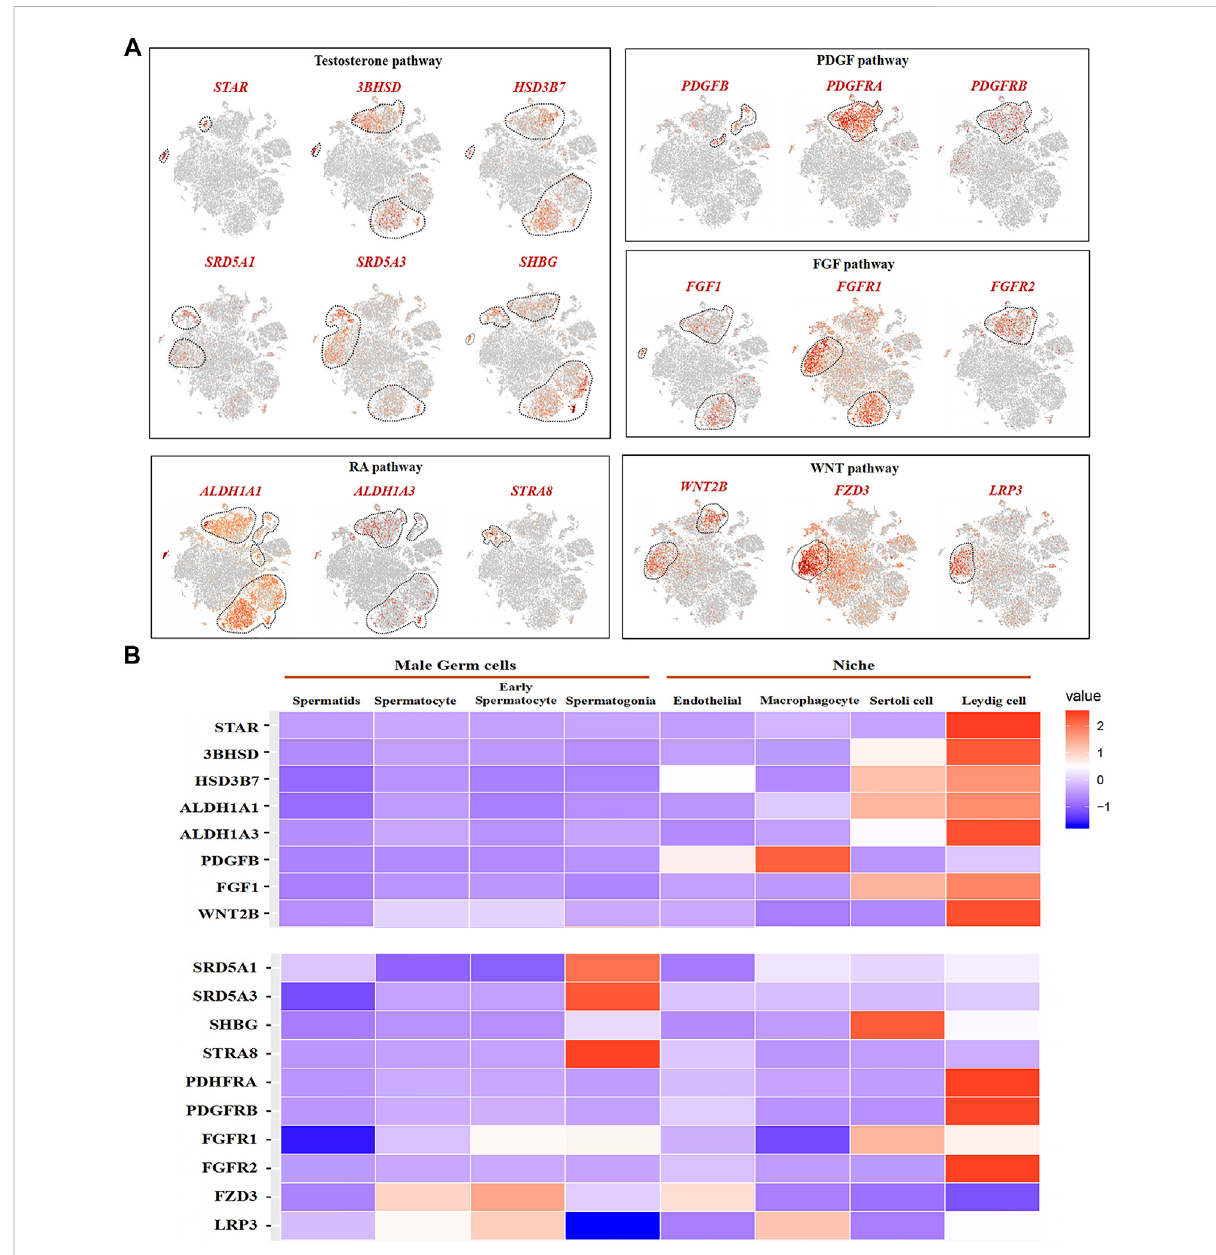
FIGURE 7 Male germ cells and niche-related gene expression of key pathways in dairy goat. (A) Male germ cells and niche-related gene expression in the tSNE plot. (B) Heat map illustrating showed related genes in the male germ cells and Niche respectively.